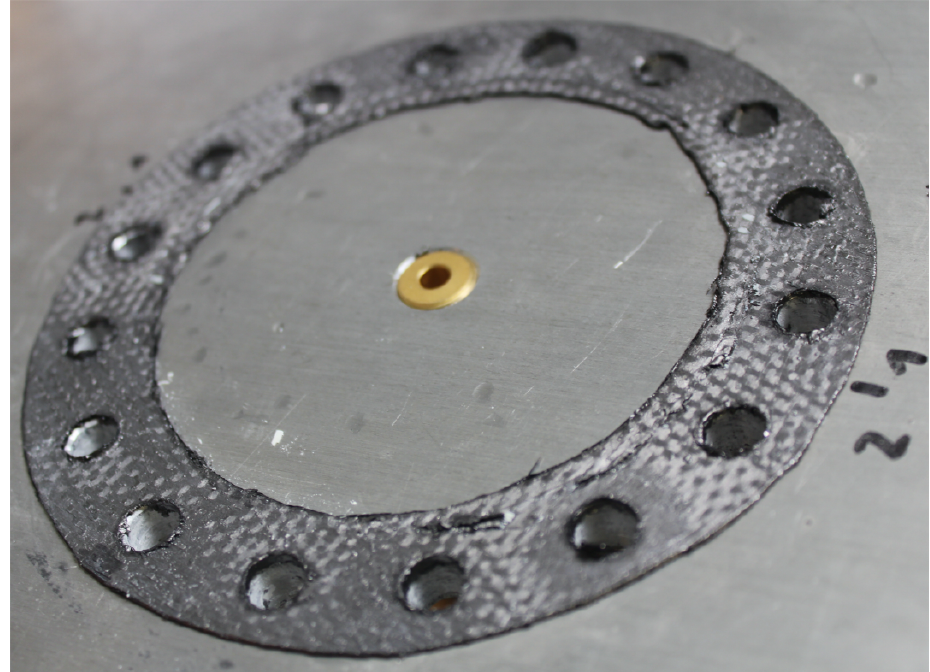
Figure 11. After disassembly, the graphite gasket shows a homogeneous imprint of the fibre structure of the CMC